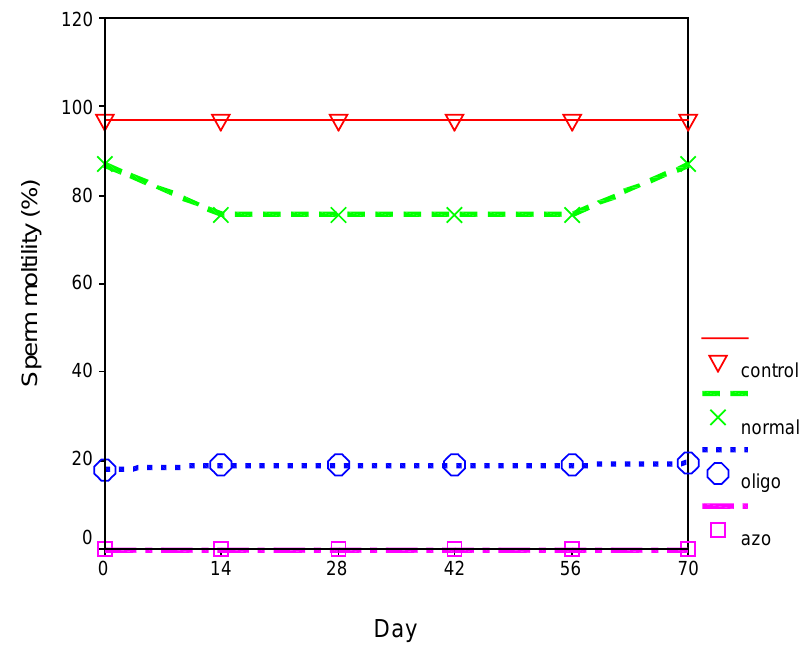
FIGURE 3 . Effect of C. populnea aqueous extract on sperm motility.